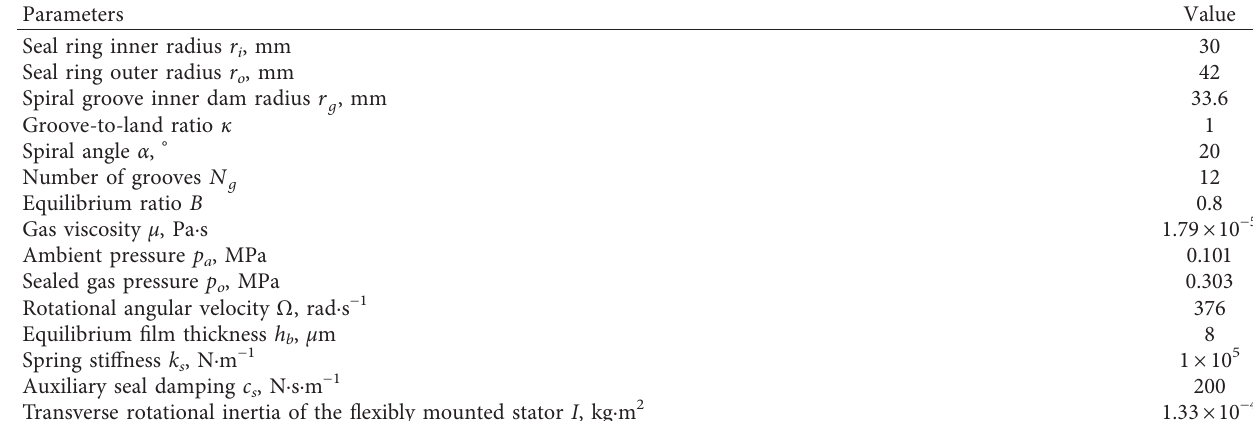
Table 2: The default values of geometric and operating parameters.